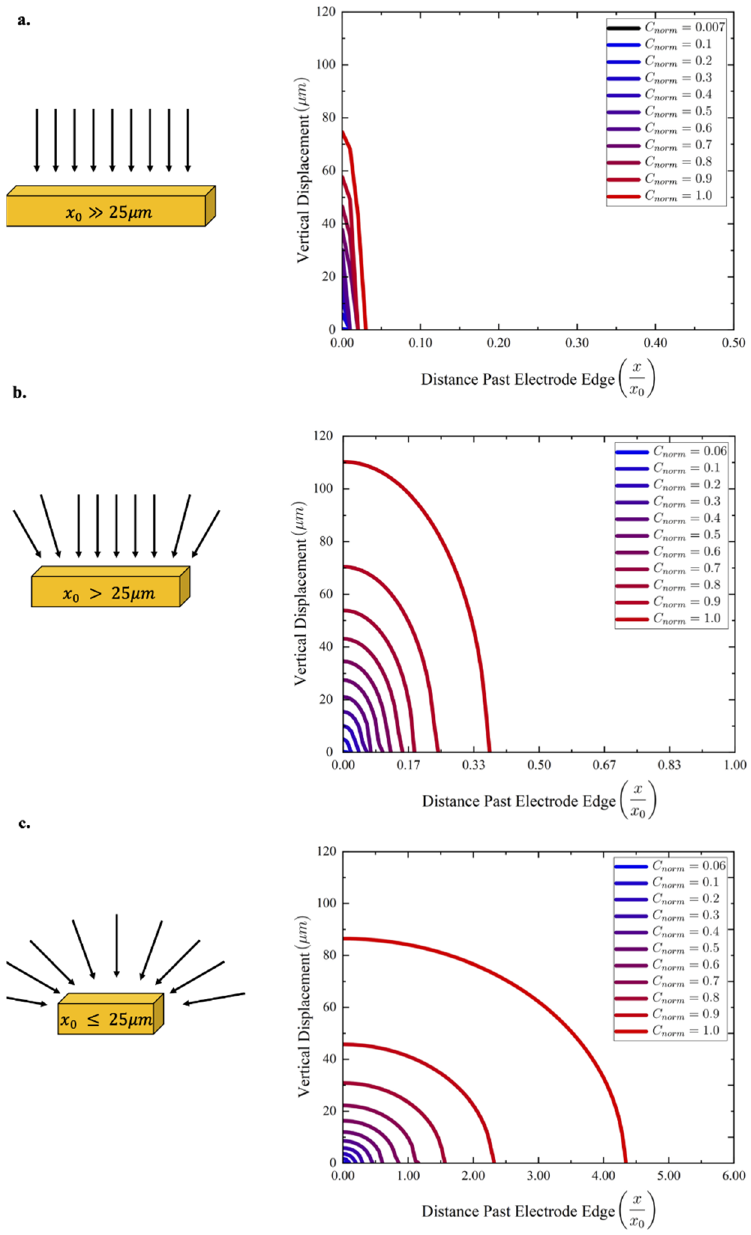
Figure 5. Normalized isoconcentration curves at different radial distances from the electrode surface, plotted along vertical versus horizontal displacement. Isoconcentration lines were plotted via Equation (5) after 1 s and are 0.1 normalized concentration units apart. The electrode edge is located at the origin of the isoconcentration plots. ( a ) (Left ) The planar diffusion vectors for a microelectrode with a critical dimension of 3 mm. ( Right ) The isoconcentration lines, featuring a steep return to the bulk concentration upon leaving the electrode edge. ( b ) (Left) The semi-hemispherical diffusion vectors for a microelectrode with a critical dimension of 300 µm. (Right) The isoconcentration lines, featuring a delayed return to the bulk concentration shortly after leaving the electrode edge. ( c ) (Left) The radially dominated diffusion vectors for a microelectrode with a critical dimension of 20µm. (Right) The isoconcentration lines, featuring a protracted return to the bulk concentration far from the electrode edge.